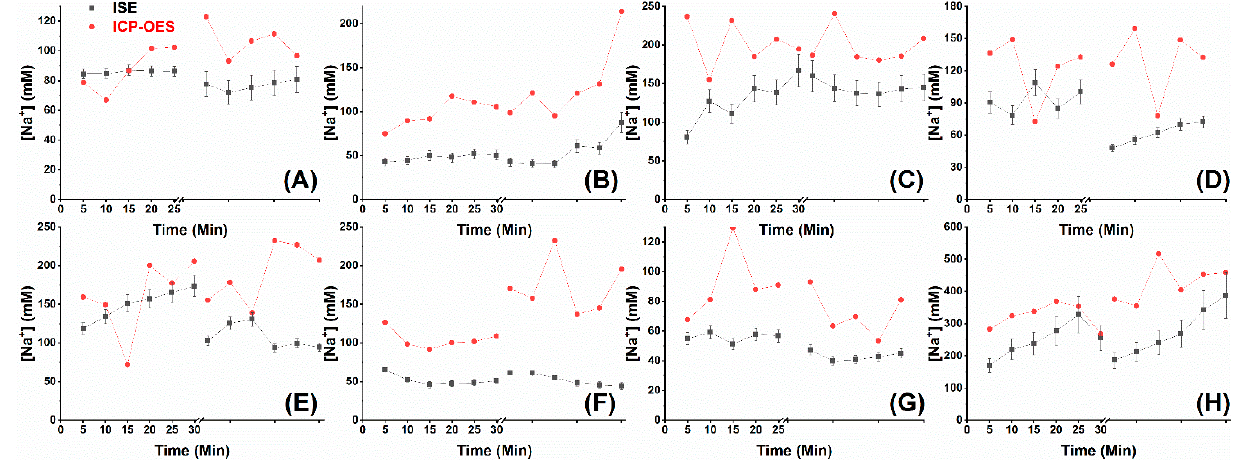
Figure 2. Time profile of the sweat sodium ions of eight volunteers ( A – H ). The data points on the left of the break on the X-axis are for the values collected for drinking purified water; while the data points on the right were collected for drinking a mineral drink. The time intervals between data points are the same in both sides of the break.